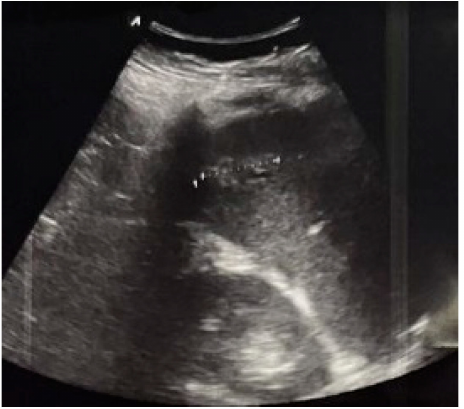
Figure 2. Splenic trauma (diameter of hyperechogenic focus 31.2